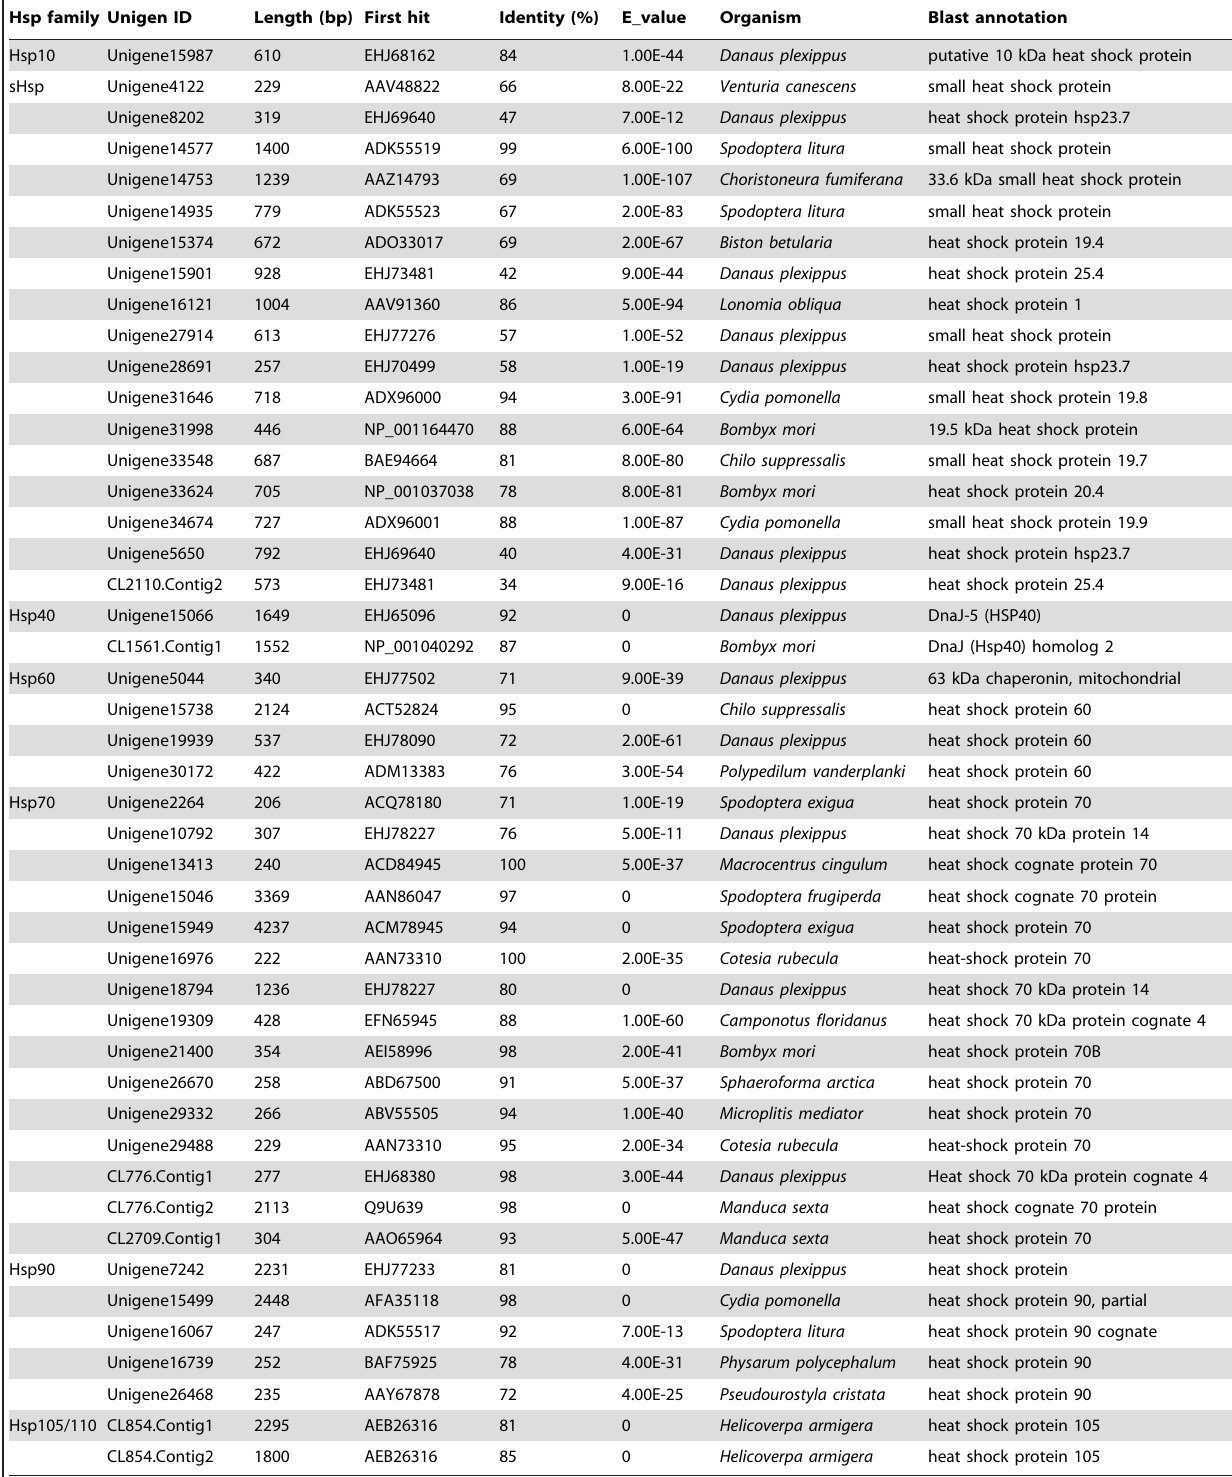
Table 3. Putatively identified heat shock protein (Hsp)